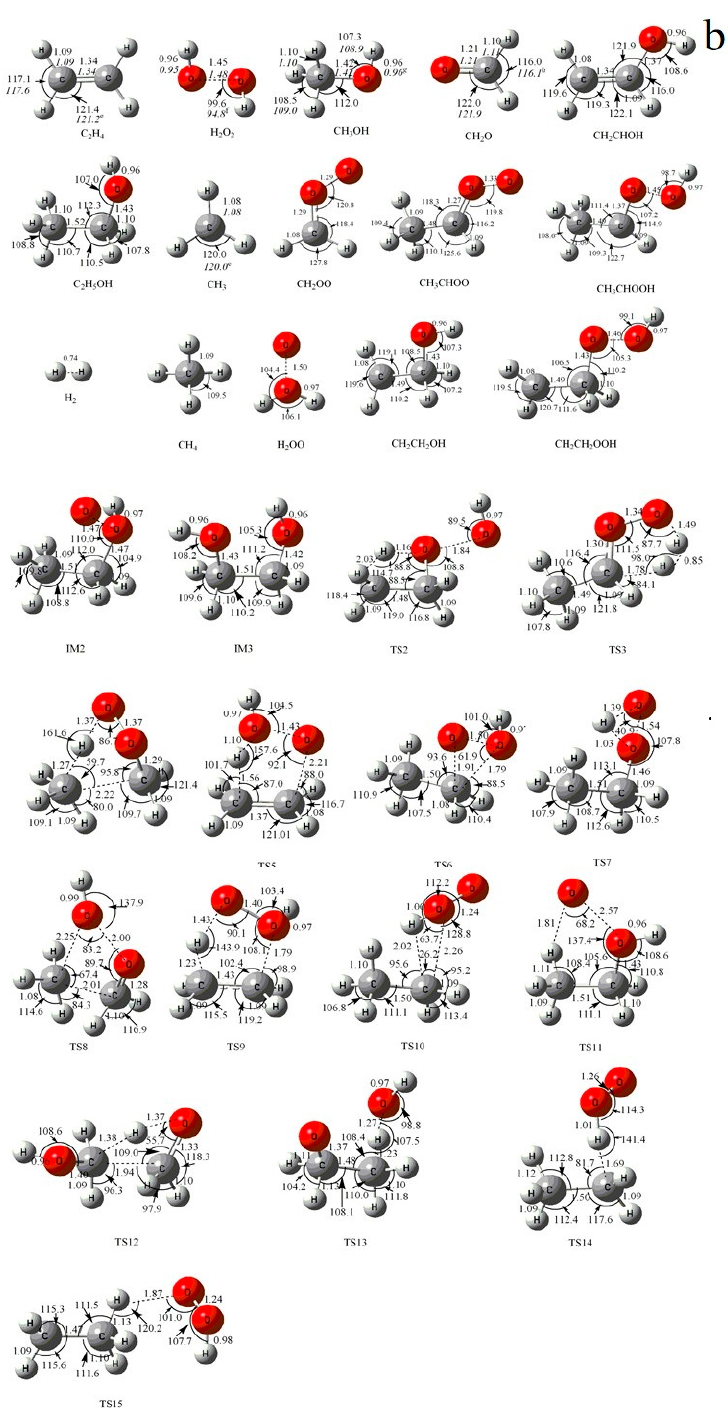
Figure 1. ( a ) MP2/6-311++G(d,p) optimized geometries for the reactants, products, intermediates (IM) and the corresponding transition states (TS) of the primary product channels of the C 2 H 5 + HO 2 reaction. ( b ) MP2/6-311++G(d,p) optimized geometries for the reactants, products, intermediates (IM) and the corresponding transition states (TS) of the secondary product channels of the C 2 H 5 + HO 2 reaction. The values in parentheses are the pertinent experimental data from the literature, and a – i represent refs. [17,18,22–28], respectively. Bond lengths are in Å, and bond angles are in degree.